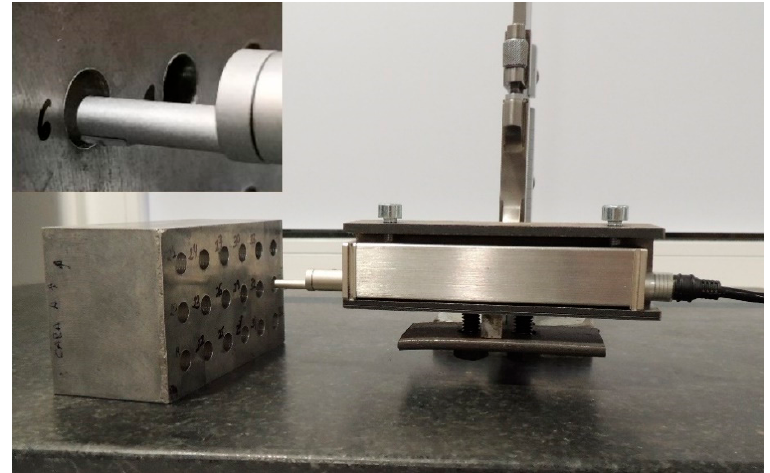
Figure 3. Surface tester Handysurf E ‐ 35A positioning system on the surface plate.